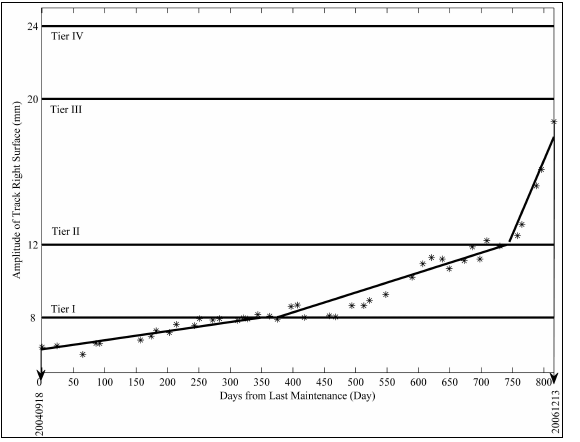
Figure 2 Actual Performance Graph of Right Track Surface at Mileage Point K669+350 in Jing-Hu Up-going Track